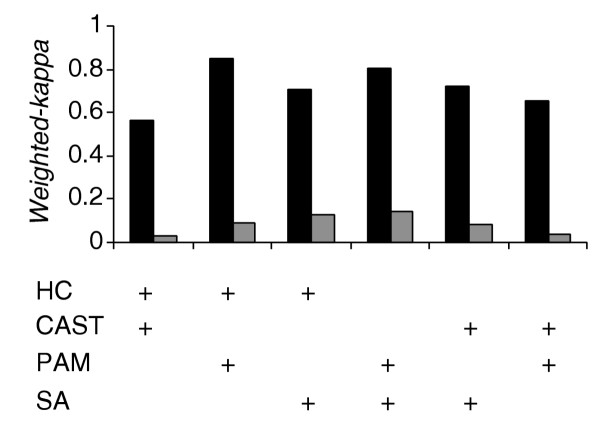
Pairwise comparison of consistency between different cluster algorithm data partitions using the weighted-kappa metric (Table 1) to score similarity. Each clustering algorithm was used to analyze the Amersham Score Card dataset (black bars) and the B-cell lymphoma dataset (gray bars), and the cluster-method agreement based on assigning the same genes to the same cluster was calculated and scored. HC, hierarchical clustering; CAST, cluster affinity search technique; PAM, partitioning around medoids; and SA, simulated annealing.